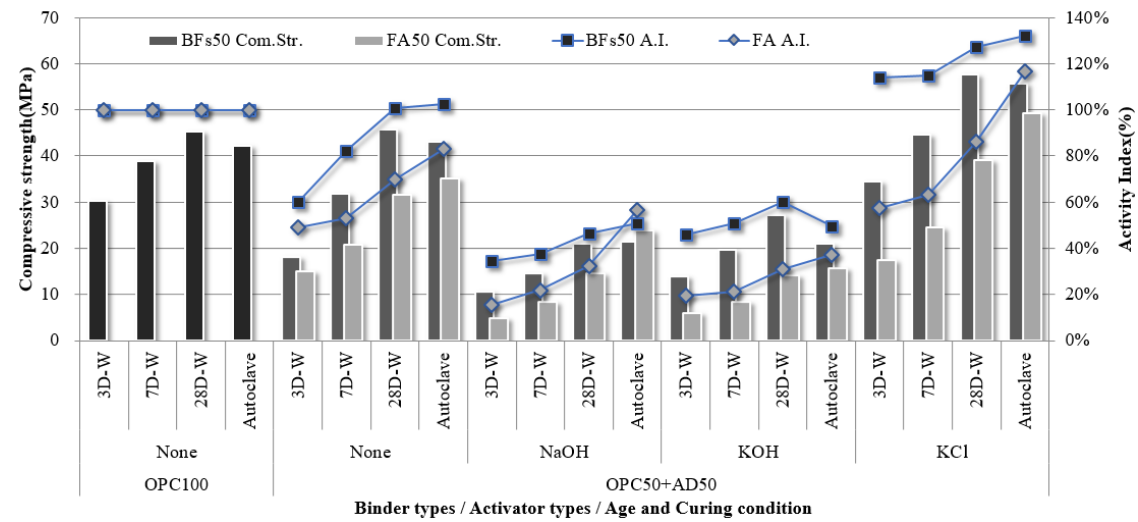
Figure 5. Compressive strength and activity index of the 50% mineral admixture (BFS or FA) and 50% OPC mortar samples with KCl separated from CBD, NaOH, and KOH as activators.